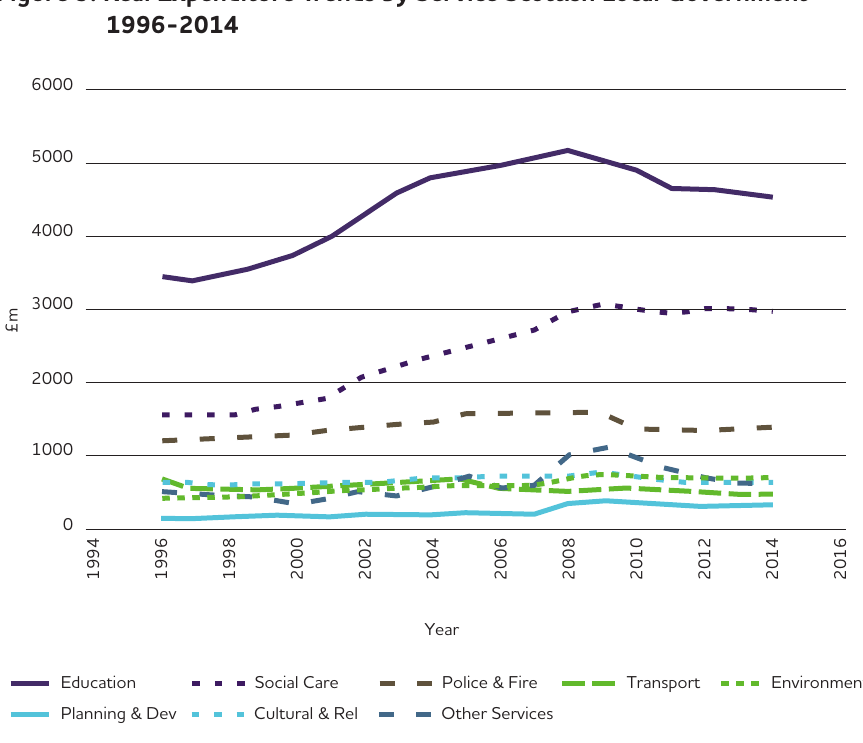
Figure 9: Real Expenditure Trends by Service Scottish Local